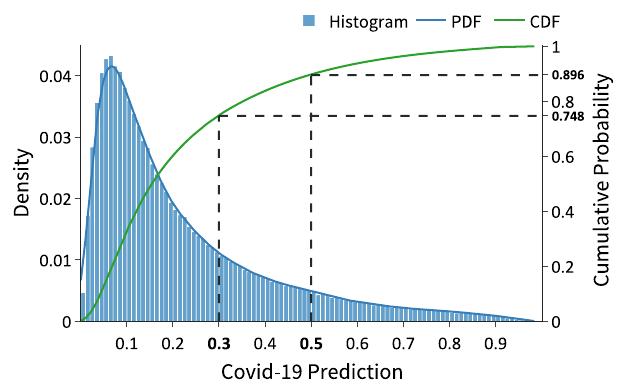
Fig. 6 Stacked model probability of predicting COVID-19 on 2019 data. Nearly 90% of the cases lie below the 50% covid probability threshold, with roughly 75% being concentrated below the 30% probability